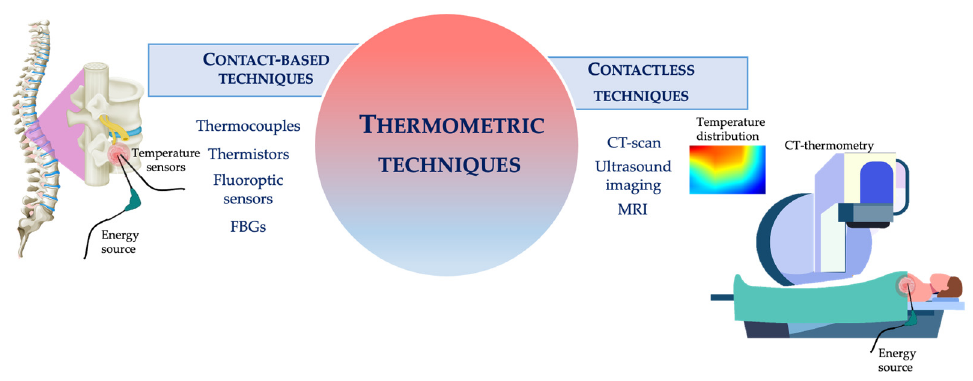
Figure 1. Schematic representation of the thermometric techniques employed during